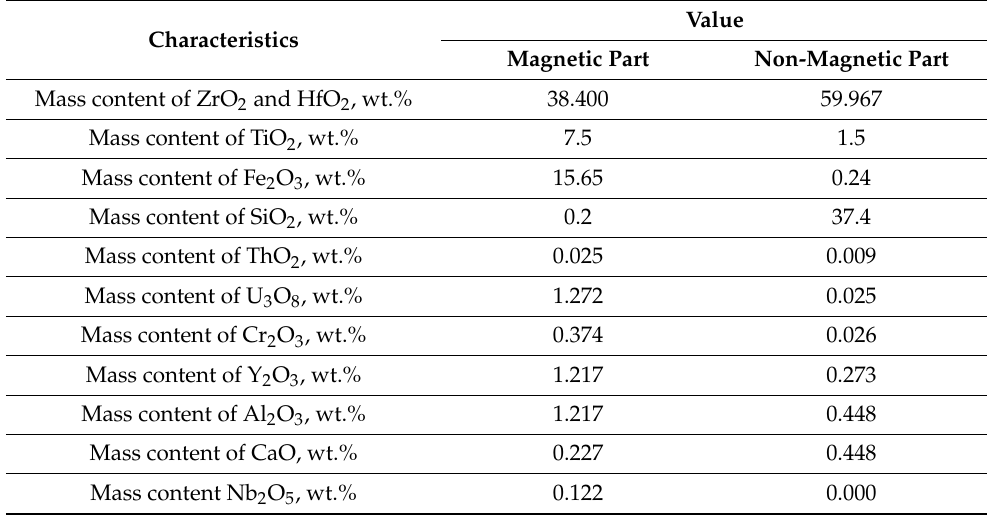
Table 5. Chemical composition of fraction 2.